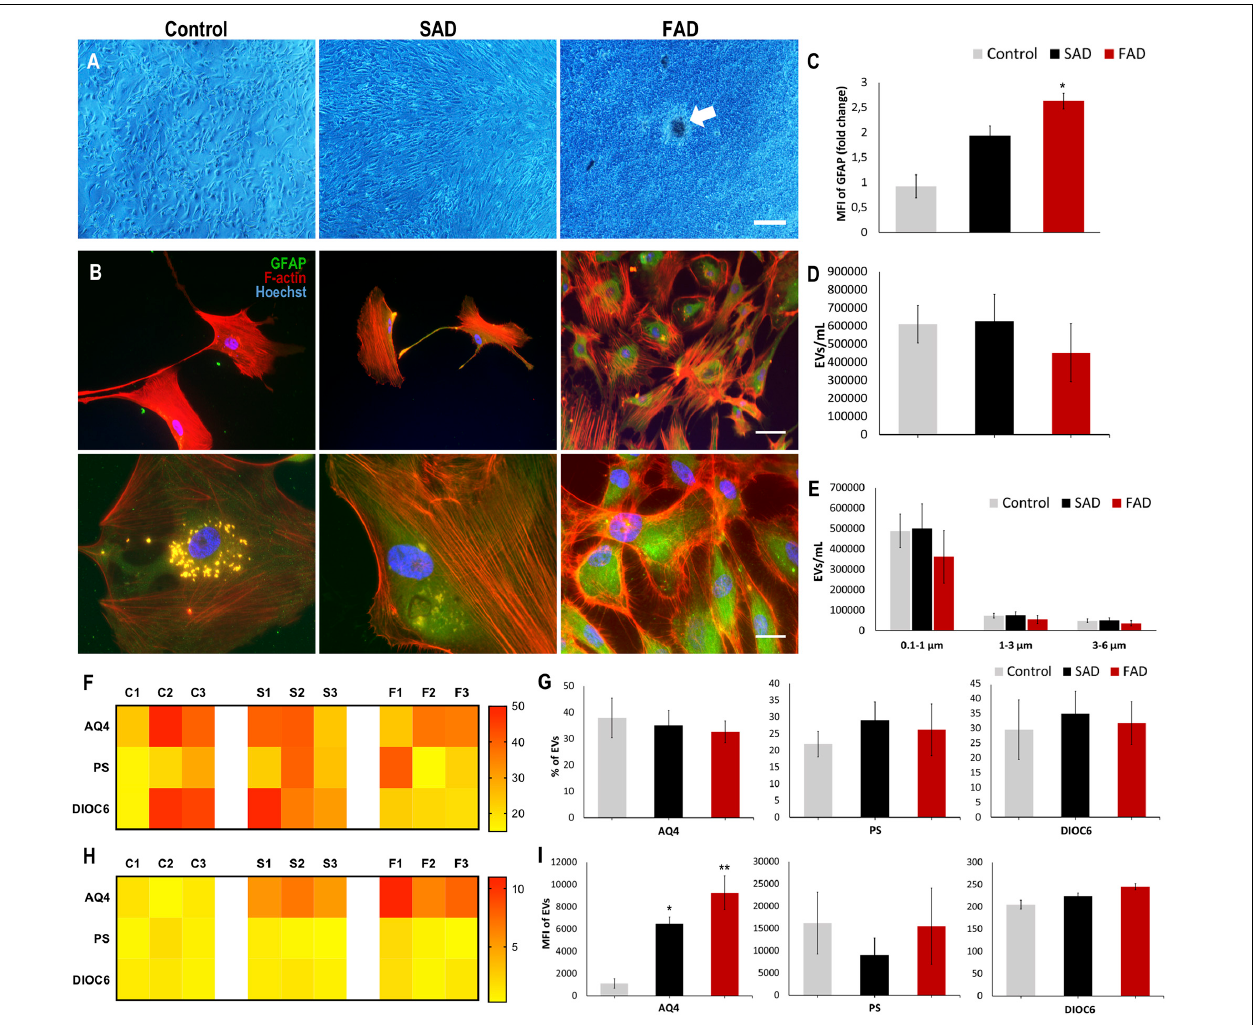
FIGURE 5 | Postmortem Human CNT, SAD and FAD astrocytes in culture and characterization of AD A-EVs. (A) Representative images show astrocyte cultures after 50 days. Magnification × 4, scale bar 40 µ m. White arrow indicates focal cell aggregates in FAD culture. (B) Morphological characterization showing the following: F-actin visualized in red, GFAP visualized in green and nuclei in blue. Magnification × 20, scale bar 100 µ m, magnification × 60, scale bar 10 µ m. (C) MFI of GFAP data seen in B. 20X Representative data from CNT, n = 2; SAD, n = 3; FAD, n = 3. (D) Concentration of EVs/mL measured by flow cytometry. (E) Concentration of EVs/mL measured In the different size intervals: MVs, 0,1-1 µ m; Apoptotic bodies, 1-6 µ m. (F) Heatmap of percentages of EVs positive for cell markers (AQ4, astrocyte; Annexin, phosphatidylserine (PS) and DIOC6, mitochondria) from each CNT, FAD, and SAD. (G) Comparative of percentages of EVs positive of cell markers for grouped data seen in panel (F) . (H) Heatmap of the normalized MFI of cell markers (to mean data from CNT individuals). (I) Comparative of MFI of cell markers for grouped data seen in panel (H) . Representative data from CNT, n = 3; SAD, n = 3; FAD, n = 3. Data was plotted as means and SEM. One-way ANOVA, Tukey’s multiple comparison test. ∗ Indicates p < 0.05; ∗∗ indicates p < 0.01.